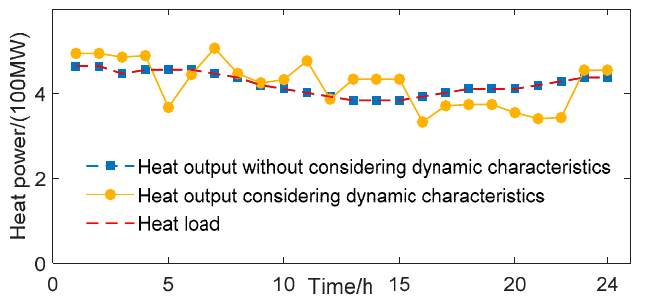
Figure 7. Relationships between heat output and load.